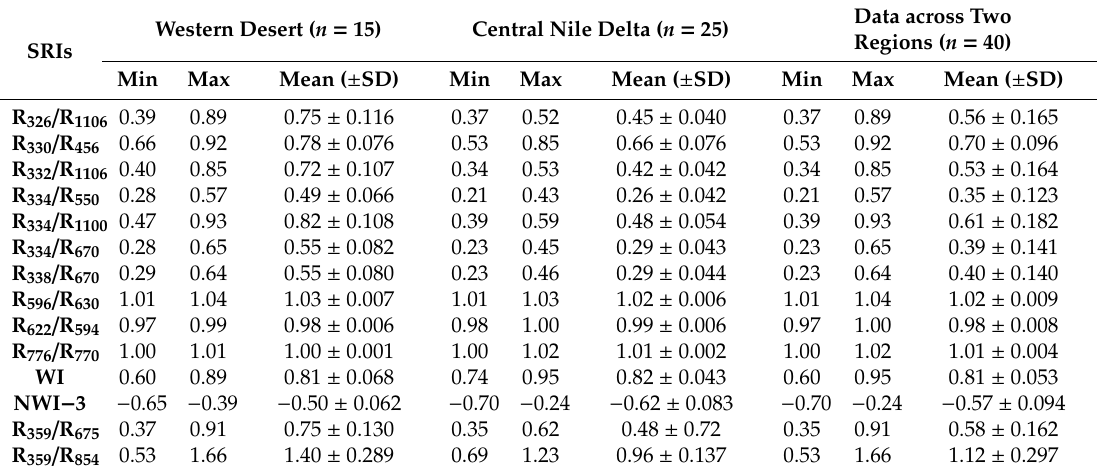
Table 6. Minimum (min), maximum (max), and mean ( ± standard deviations (SD)) values of di ff erent spectral reflectance indices (SRIs) for groundwater samples of the Western Desert and Central Nile